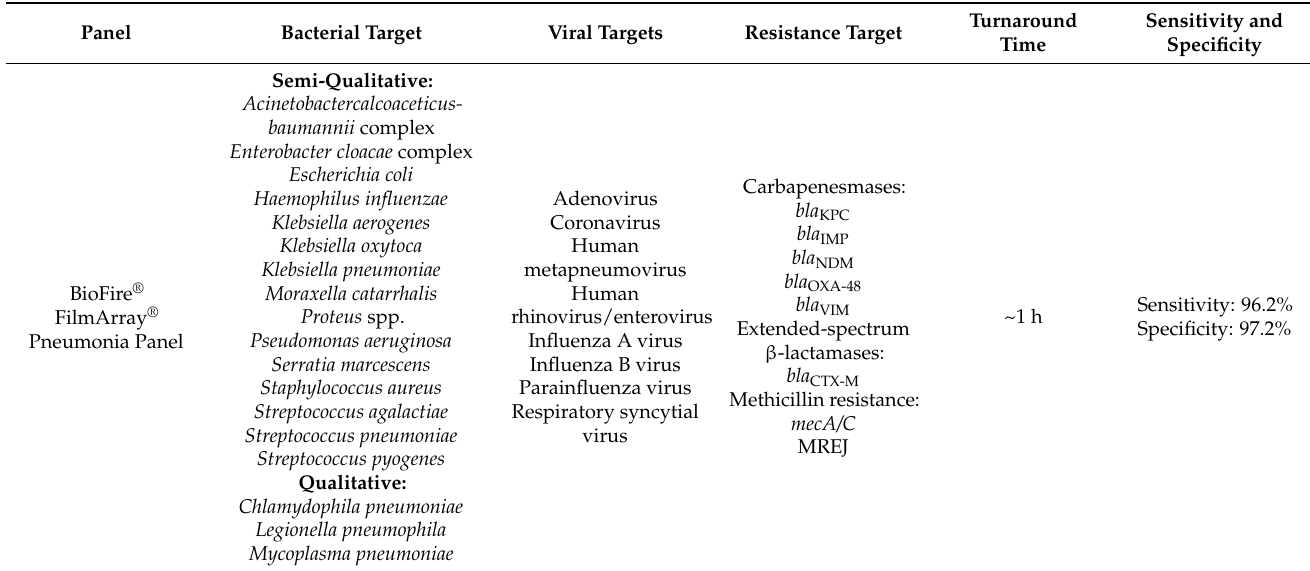
Table 1. Comparison of Various Rapid Respiratory Panels [56].